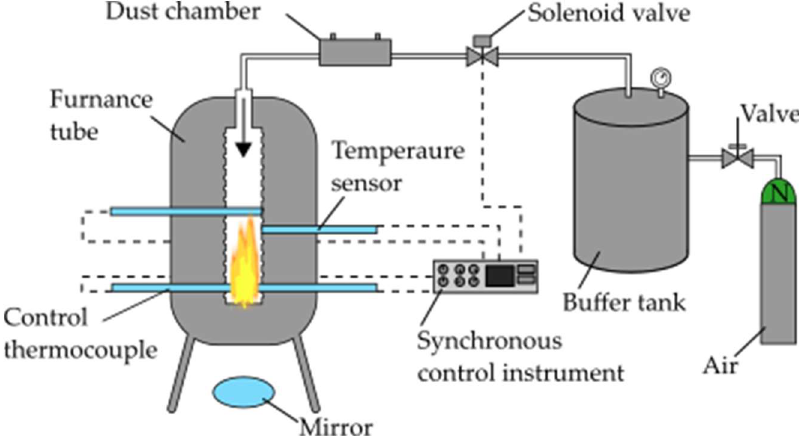
Figure 4. Measurement device for minimum ignition temperature of Holi dust cloud.